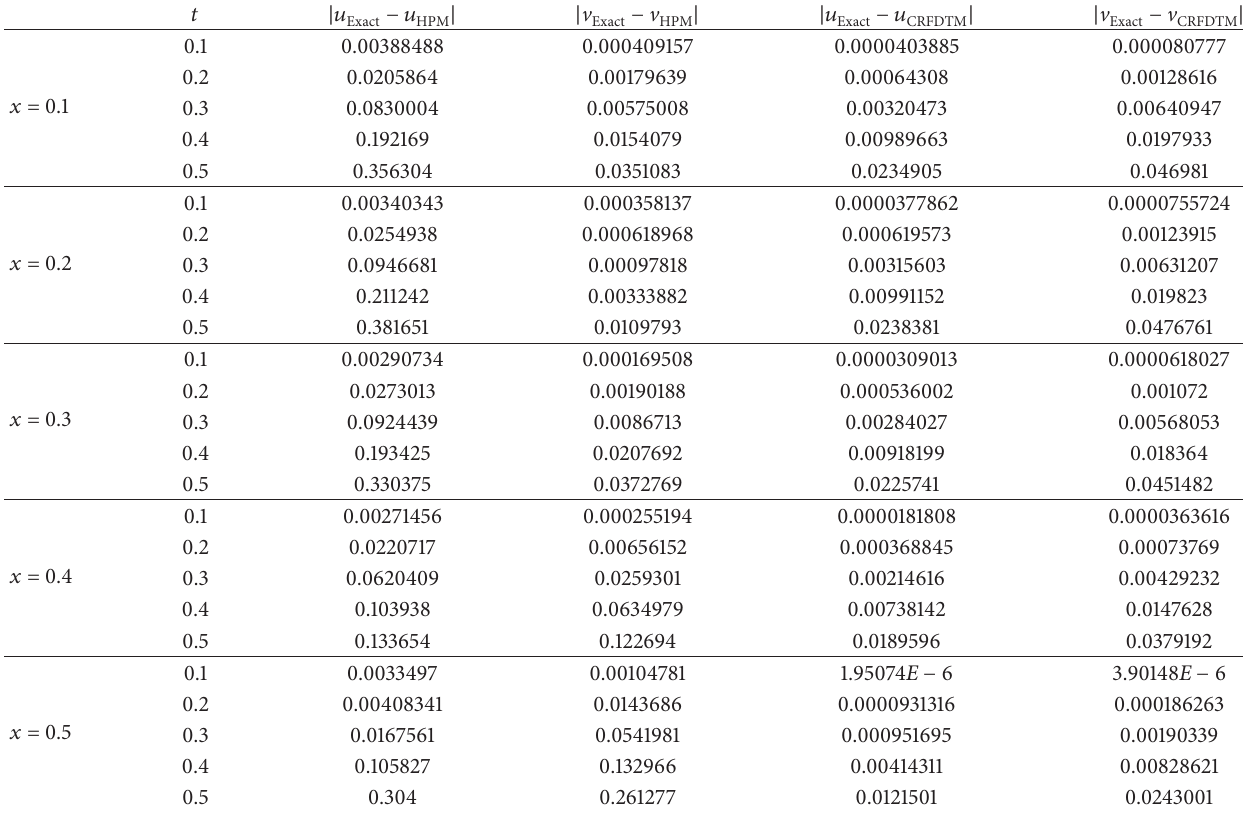
Table 2: The comparison of results obtained in proposed method with HPM when 𝑦 = 0.3, 𝛼 = 1 , and 𝛽 = 1